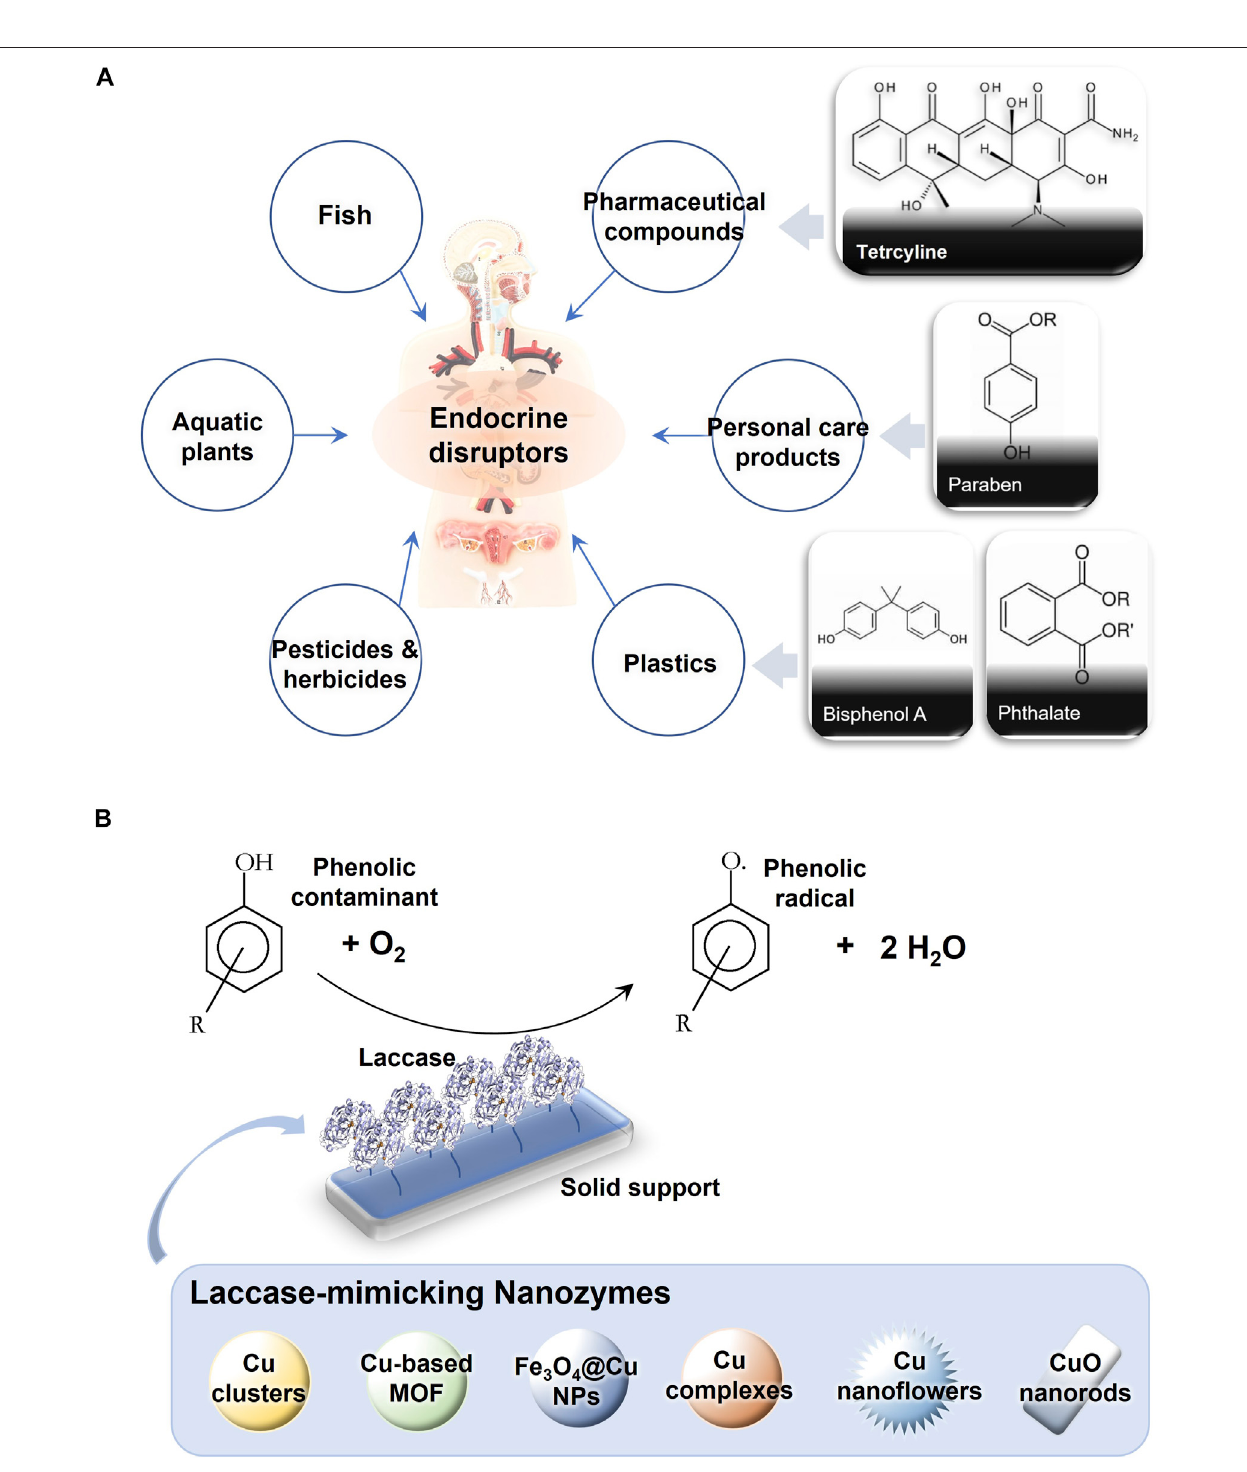
FIGURE1|(A) Commonsourcesandtypical structuresofendocrinedisruptorsinwaterenvironment. (B) Schemeofimmobilizedlaccase-assisteddegradationof phenolic contaminants and the representative nanozymes that have been reported the catalytic activities of mimicking laccase.